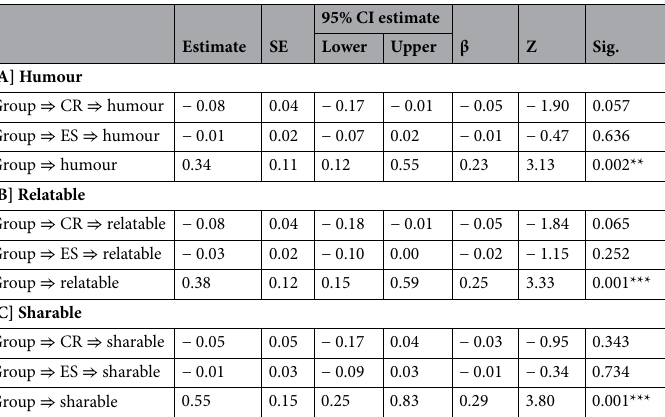
Table 3. Examination of the mediating effect of emotion regulation, with meme ratings as the dependent variables and group status as the predictor. Mediation model, 1000 bias corrected bootstrapped samples; CR, cognitive reappraisal; ES, expressive suppression. ** < 0.01, *** <